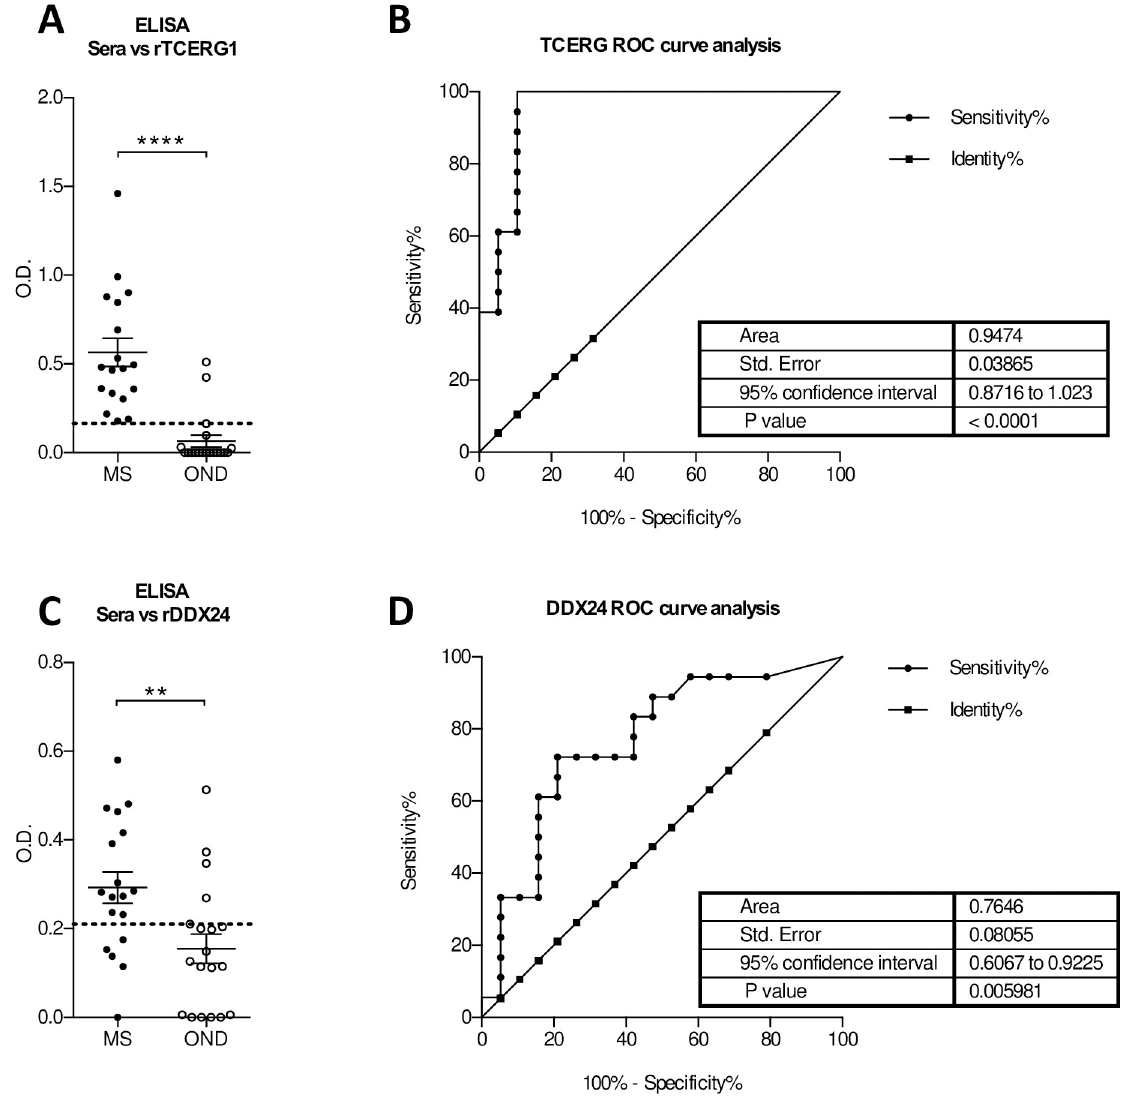
Fig 4. Evaluation of the diagnostic value of DDX24 and TCERG1 in the prediction of MS. Serum response against recombinant TCERG1 (A) and DDX24 (C) in MS (n = 18) and OND (n = 19) patients (cohort 3, Table 1) measured by ELISA. ROC analysis of TCERG1 (B) and DDX24 (D) to distinguish MS from OND patients. Dotted lines represent the cut-off with the highest Youden’s index. Unpaired t- test has been used in A and C ; �� p < 0.01, ��� p < 0.001, ���� p < 0.0001.